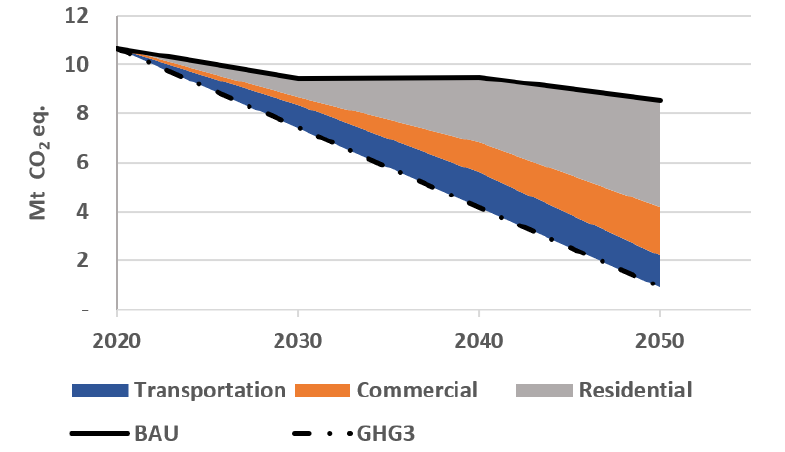
Figure 5. Contribution of each sector in the total GHG reductions in the deep decarbonization environmental scenario (GHG3) compared with the reference scenario (BAU).